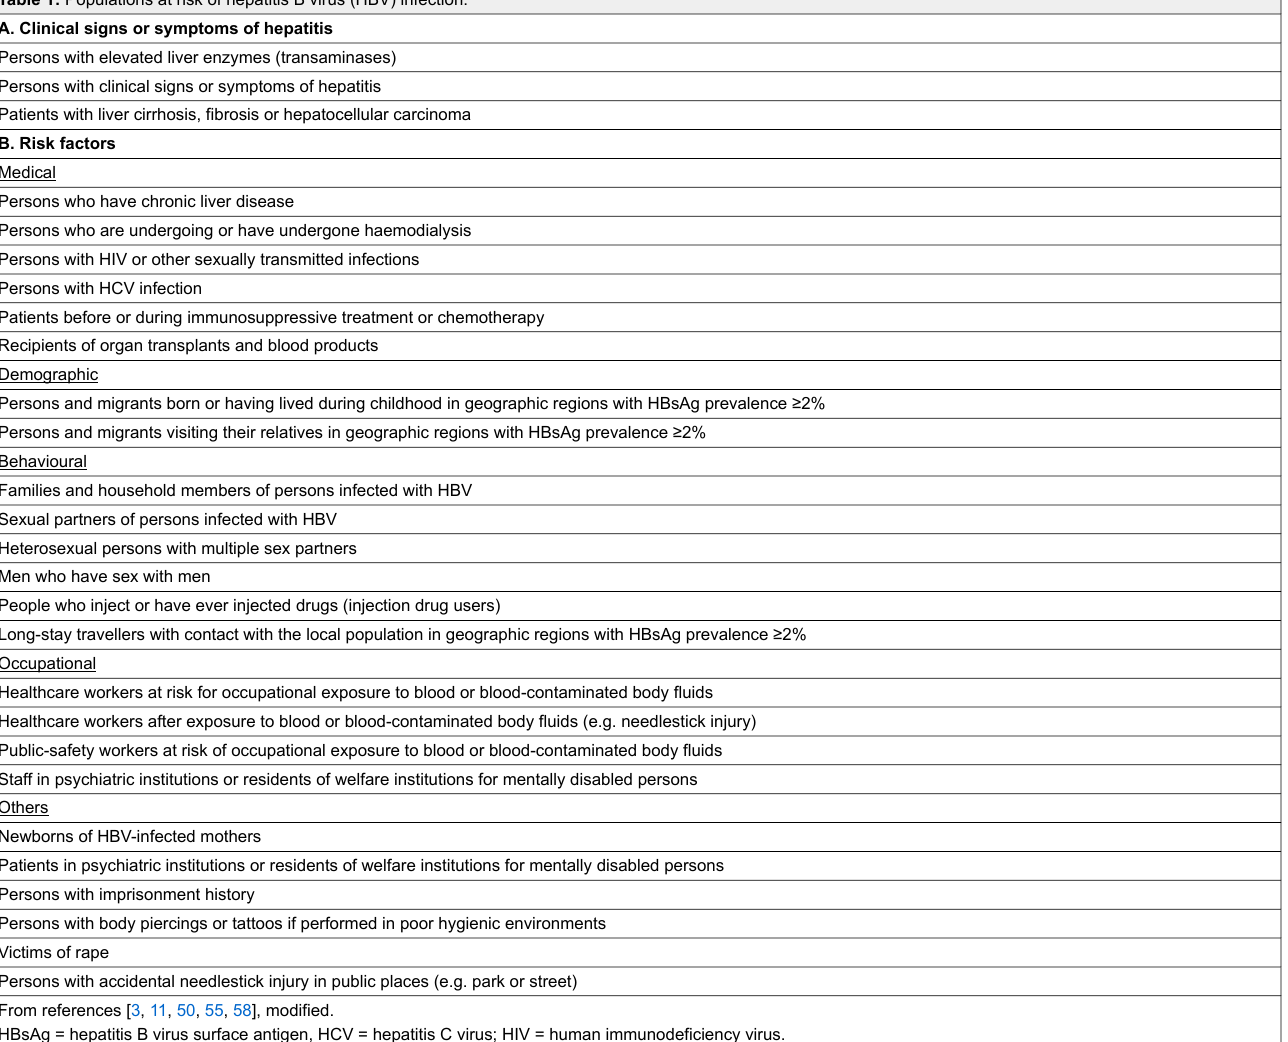
Table 1: Populations at risk of hepatitis B virus (HBV)